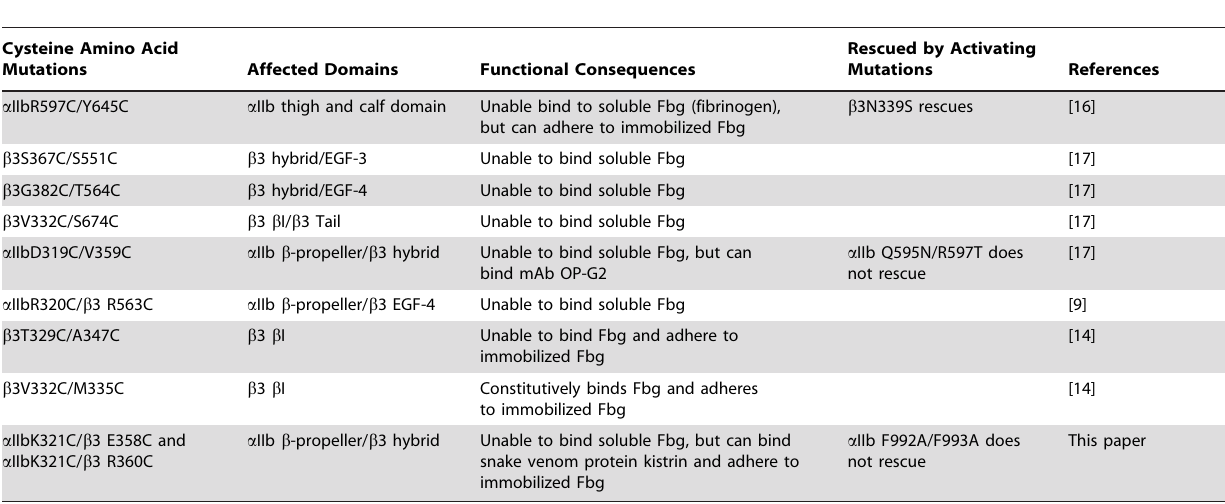
Table 1. Cysteine mutations in a IIb b 3 designed to limit or stabilize conformational changes.